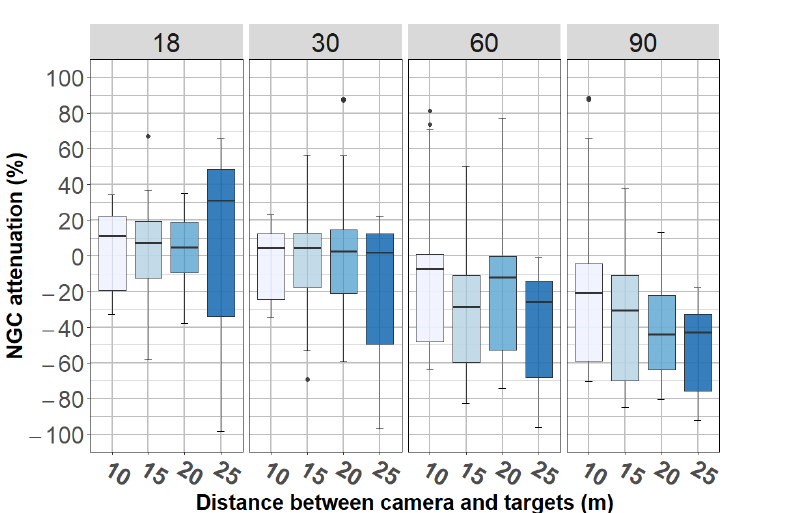
Figure 20. Contrast attenuation according to camera-to-target distance and